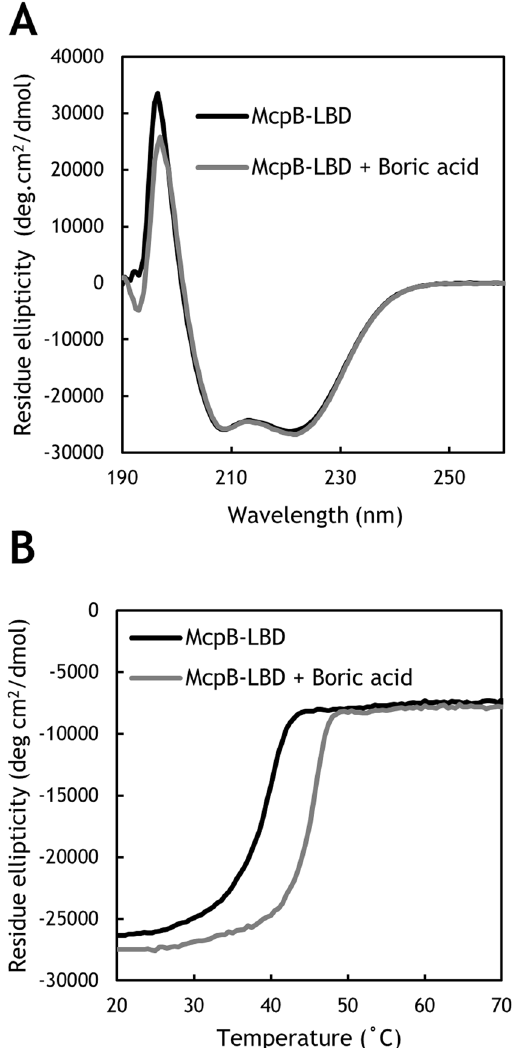
Figure 5. Circular dichroism (CD) spectroscopic analysis of McpB LBD. ( A ) CD spectra of 20 μ M McpB LBD in the absence and presence of 100 μ M boric acid. ( B ) Thermal denaturation of 20 μ M McpB LBD in the absence and presence of 100 μ M boric acid as determined by CD ellipticity at 222 nm. Shown are average curves from triplicate